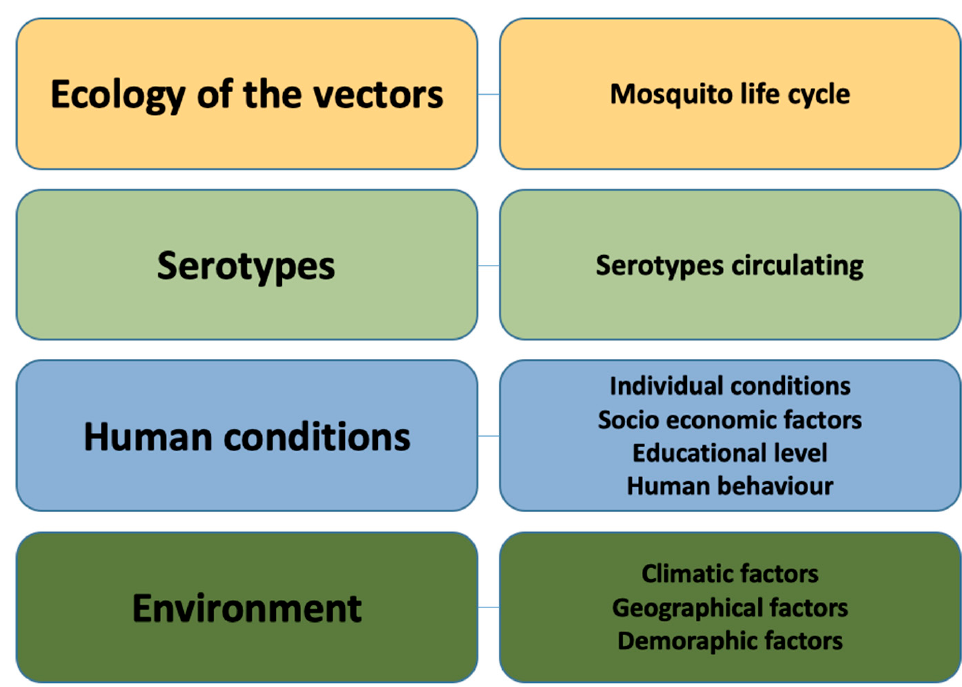
Figure 1. Risk factors of dengue fever are classified into four One Health groups: (i) ecology of the vectors, (ii) serotypes, (iii) human conditions, and (iv) environment.